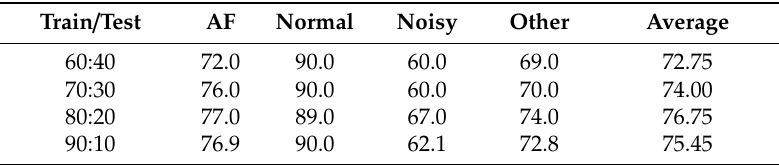
Table 4. F 1 scores using di ff erent train / test